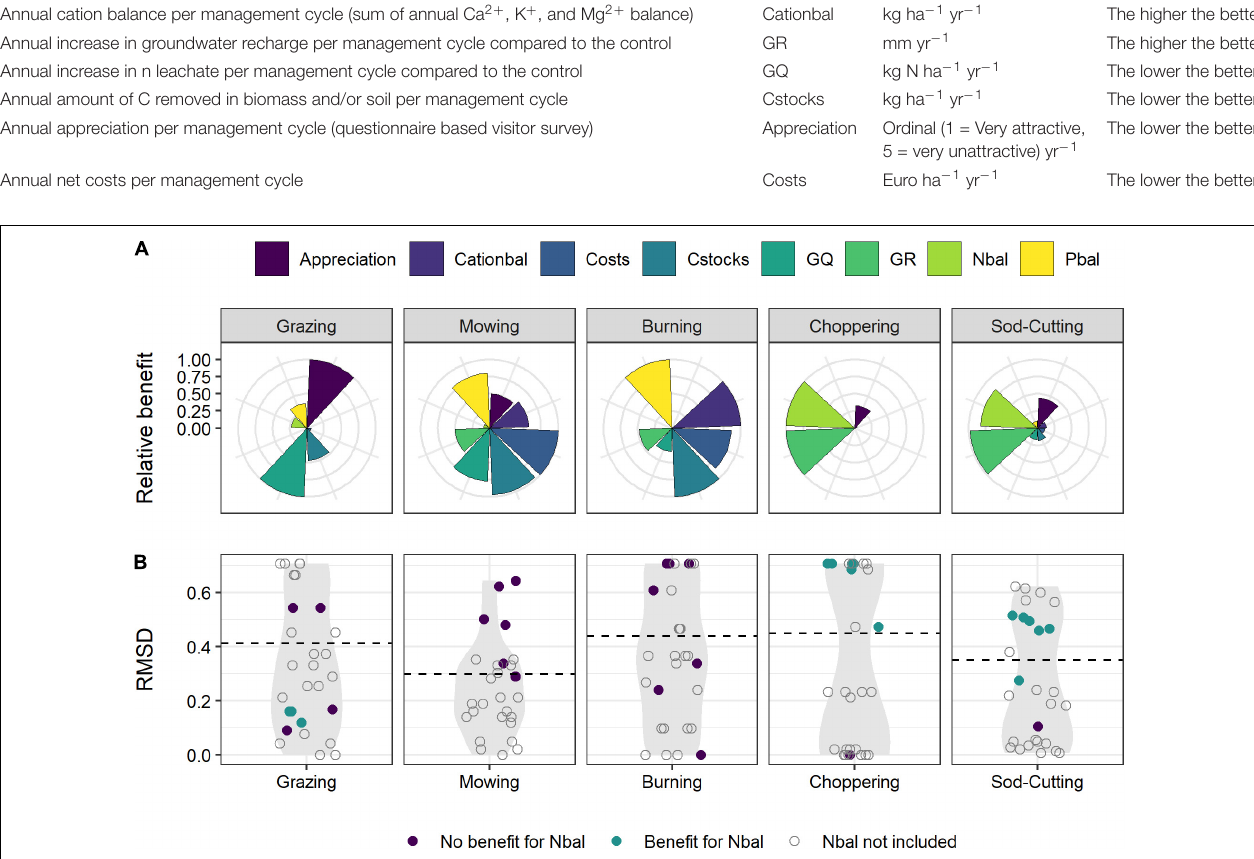
FIGURE 2 | Relative benefits and trade-offs associated with heathland management practices. (A) Segment diagrams showing the relative benefit of trade-off components within and between management practices. (B) Violin plots depicting the trade-offs for all pairwise component comparisons (circles) calculated as the residual mean square deviation (RMSD, section “Trade-Off Analysis”) and the corresponding density distribution (gray shading) for individual management practices. The total trade-off (RMSD total ), i.e., when all components are considered together, is shown as a dashed line. Pairwise comparisons that do not include the N balance (Nbal) are shown as open circles whilst those that are beneficial for the N balance and those where the benefit is not in favor of the N balance are shown as green and dark blue circles, respectively. Abbreviations as in Table 2 .